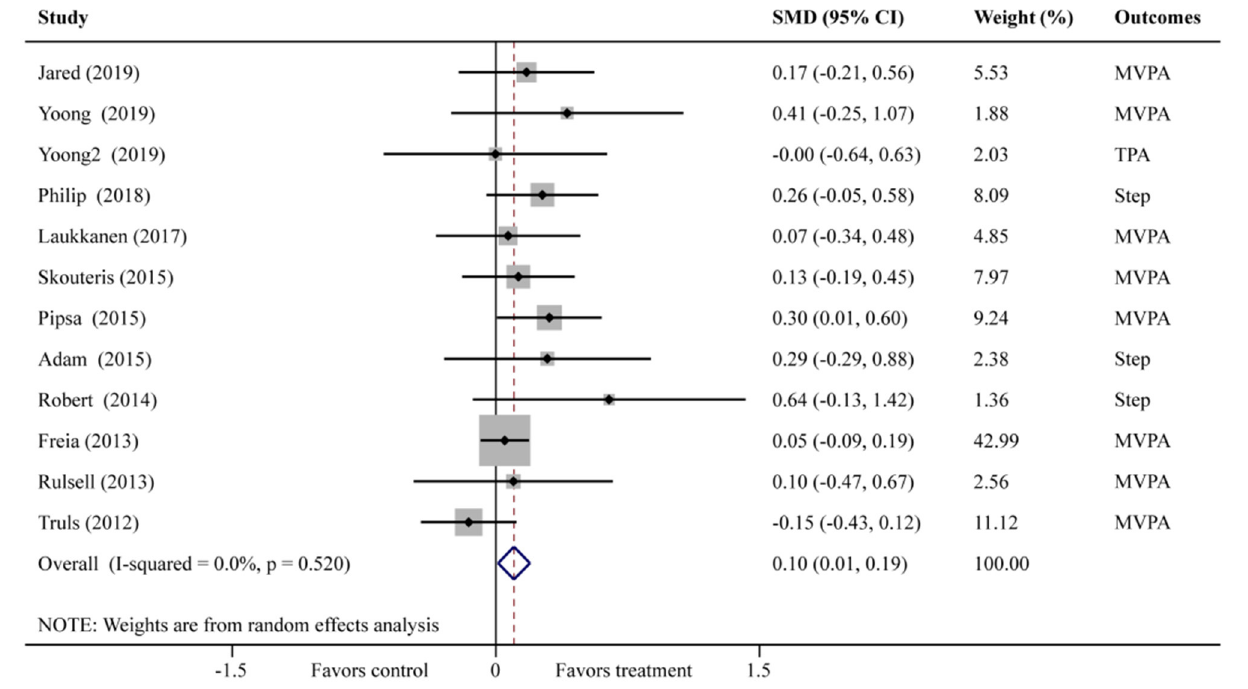
FIGURE 4 | Forest plot of family intervention on PA in children aged 2.5–12 years. (Yoong-MVPA; Yoong2-TPA).